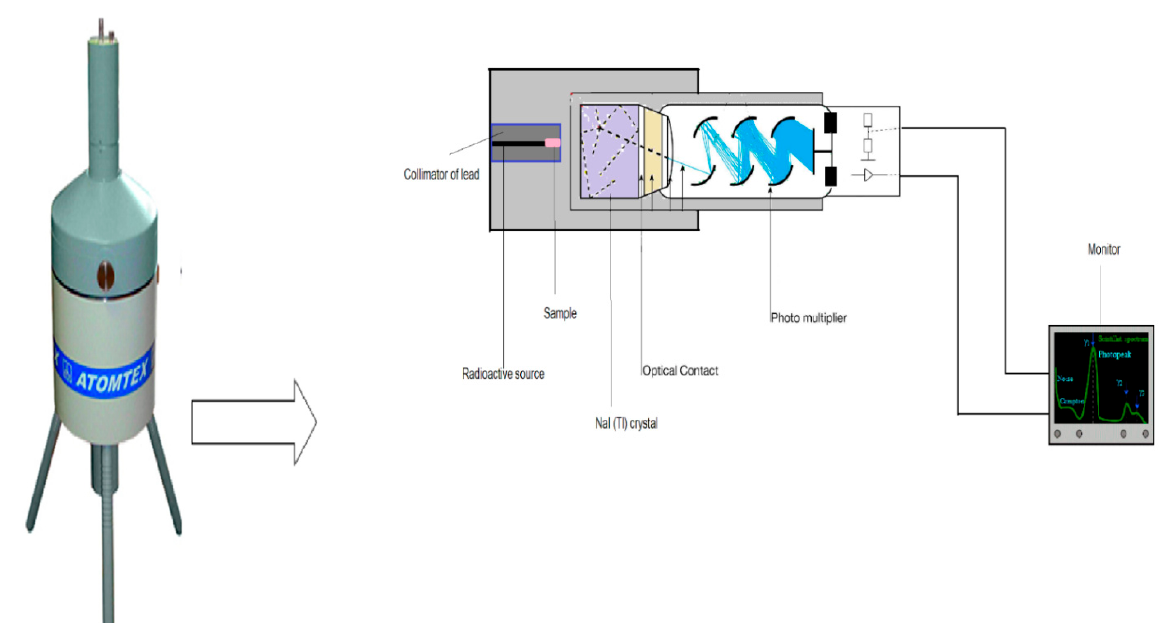
Figure 2. The experimental setup for the attenuation factors measurements.